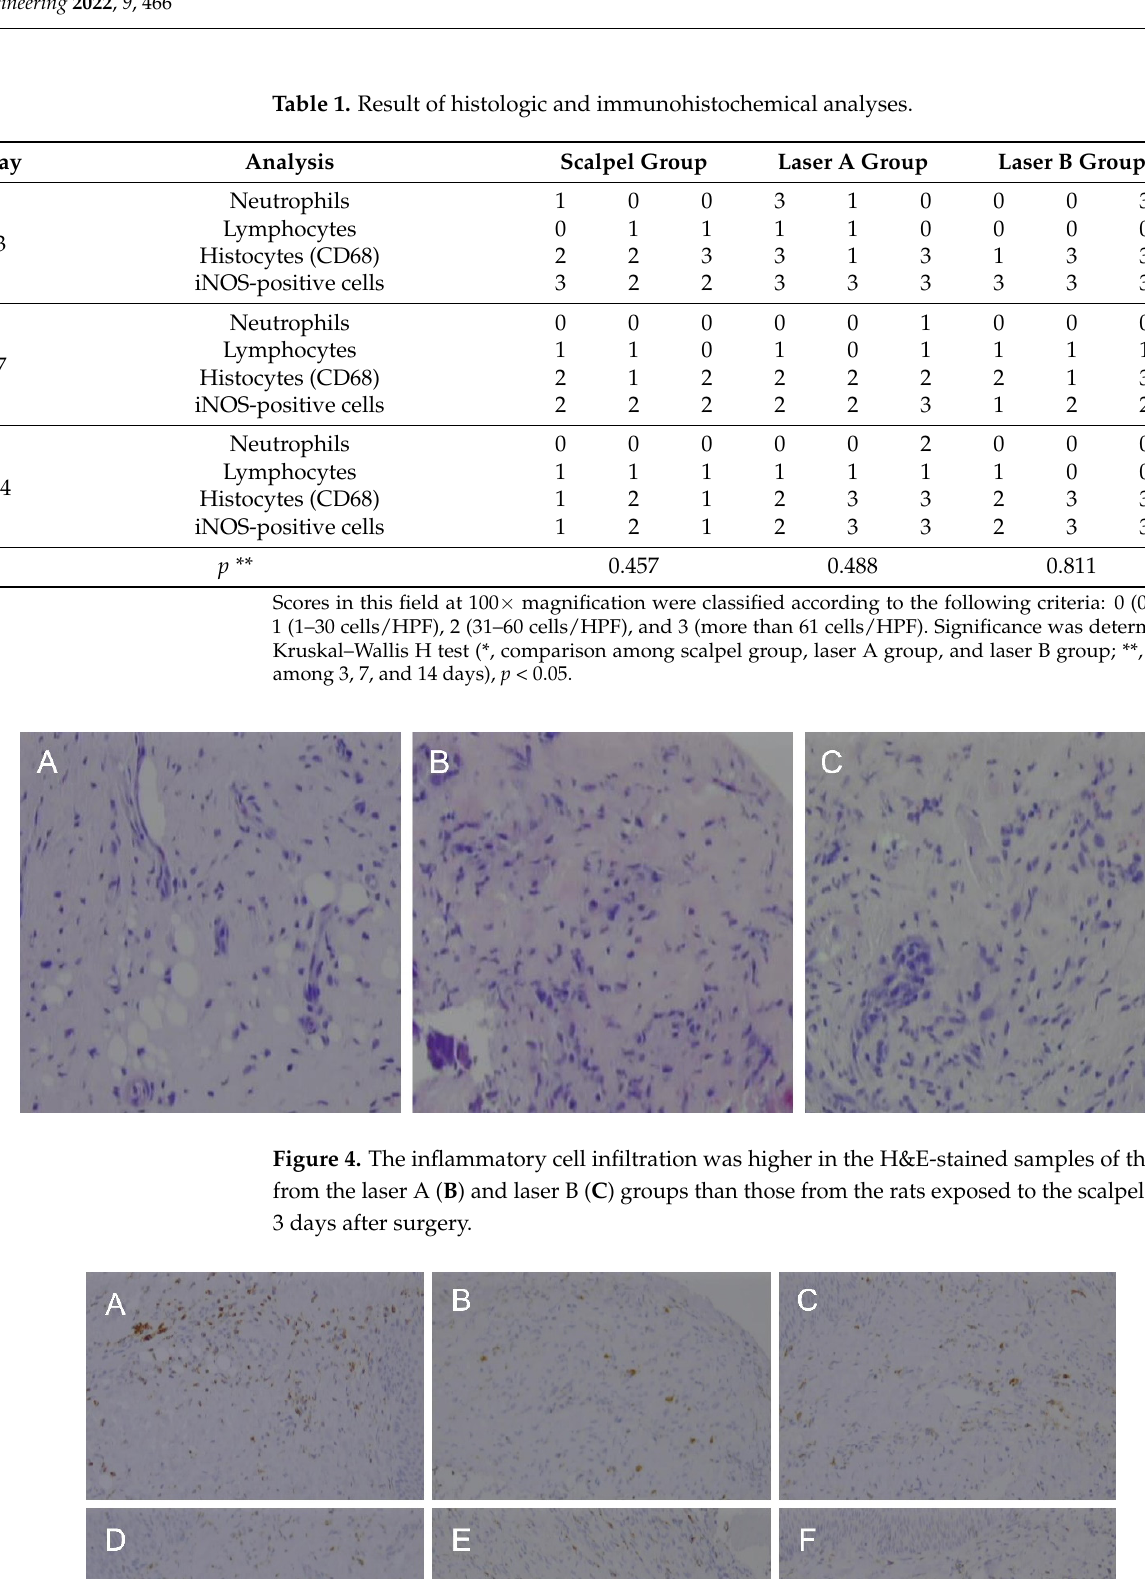
Figure 5. Expression of CD68 in the rat palate tissue after 3 days ( A – C ), 7 days ( D – F ), and 14 days ( G – I ). Scalpel ( A , D , G ), laser A ( B , E , H ), and laser B ( C , F , I ).